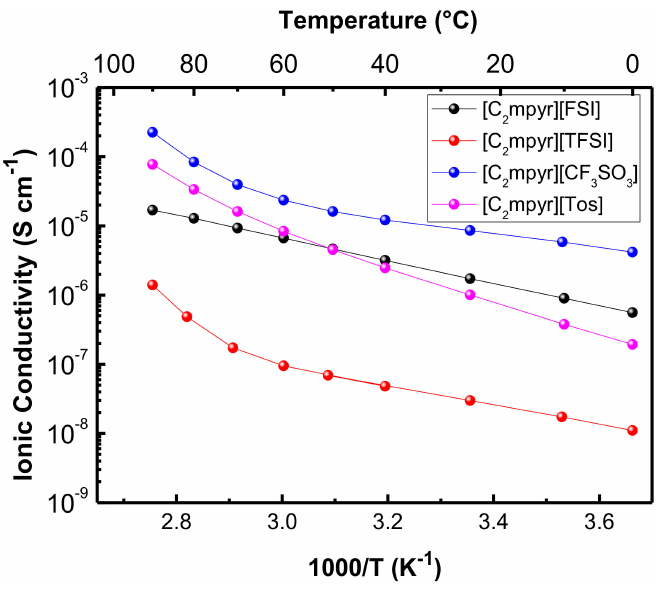
Figure 7. Ionic conductivity of OIPCs with di ff erent